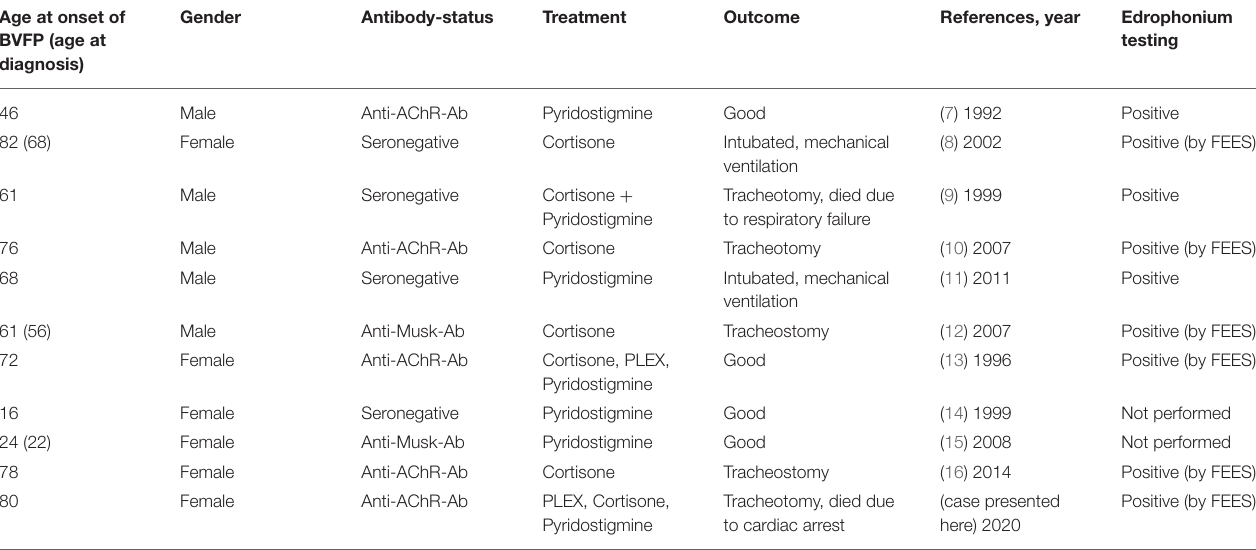
TABLE 1 | Overview of reported cases of MG presenting with BVFP. Age at onset of BVFP (age